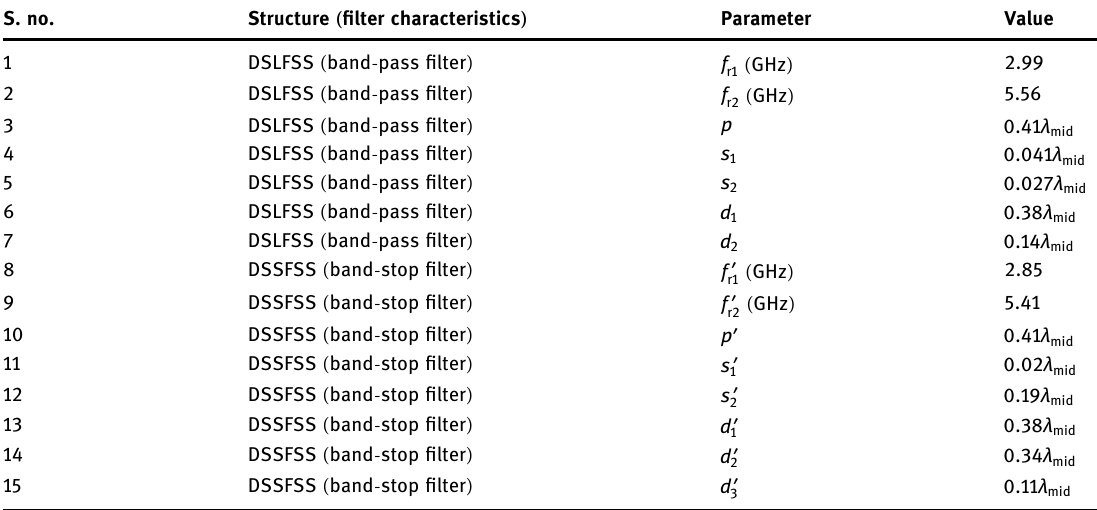
Table 1: Unit cell dimensions of DSLFSS and DSSFSS geometries for CPFSS structure S. no.